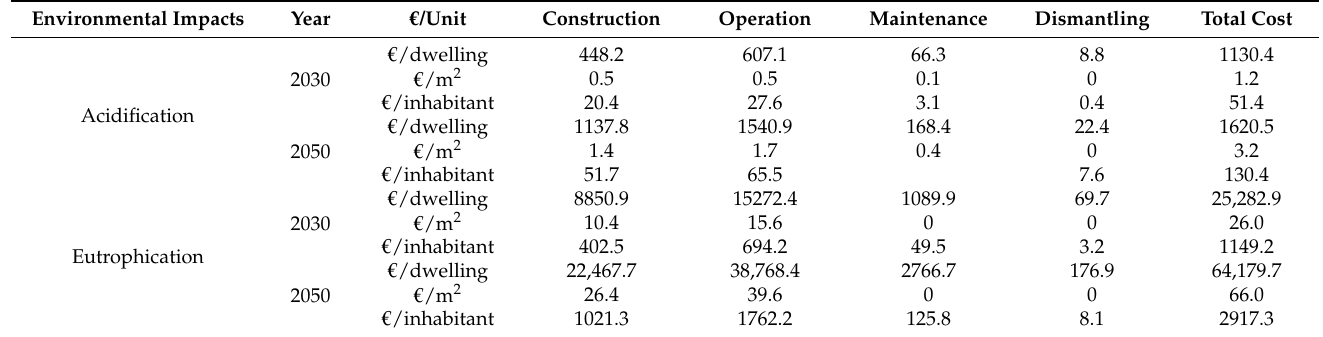
Table 4. The average environmental cost of each phase of the eco-neighborhood in